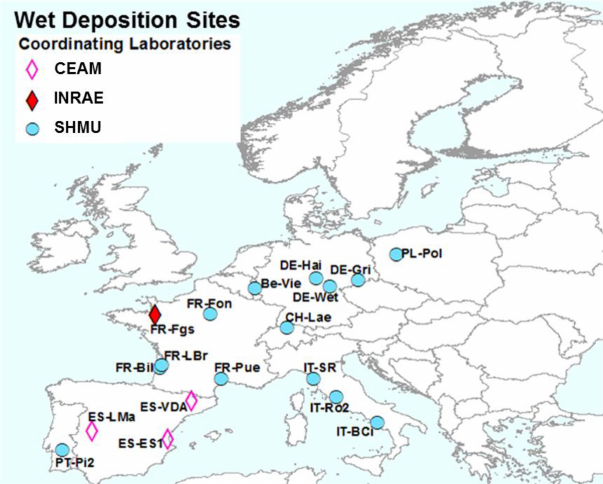
Figure 3. NitroEurope (NEU) bulk wet-deposition network sites operated between 2008 and 2010. The colour of the symbols indi- cates the responsible laboratories: CEAM (the Mediterranean Cen- tre for Environmental Studies), INRAE (French National Research Institute for Agriculture, Food and Environment), and SHMU (Slo- vak Hydrometeorological